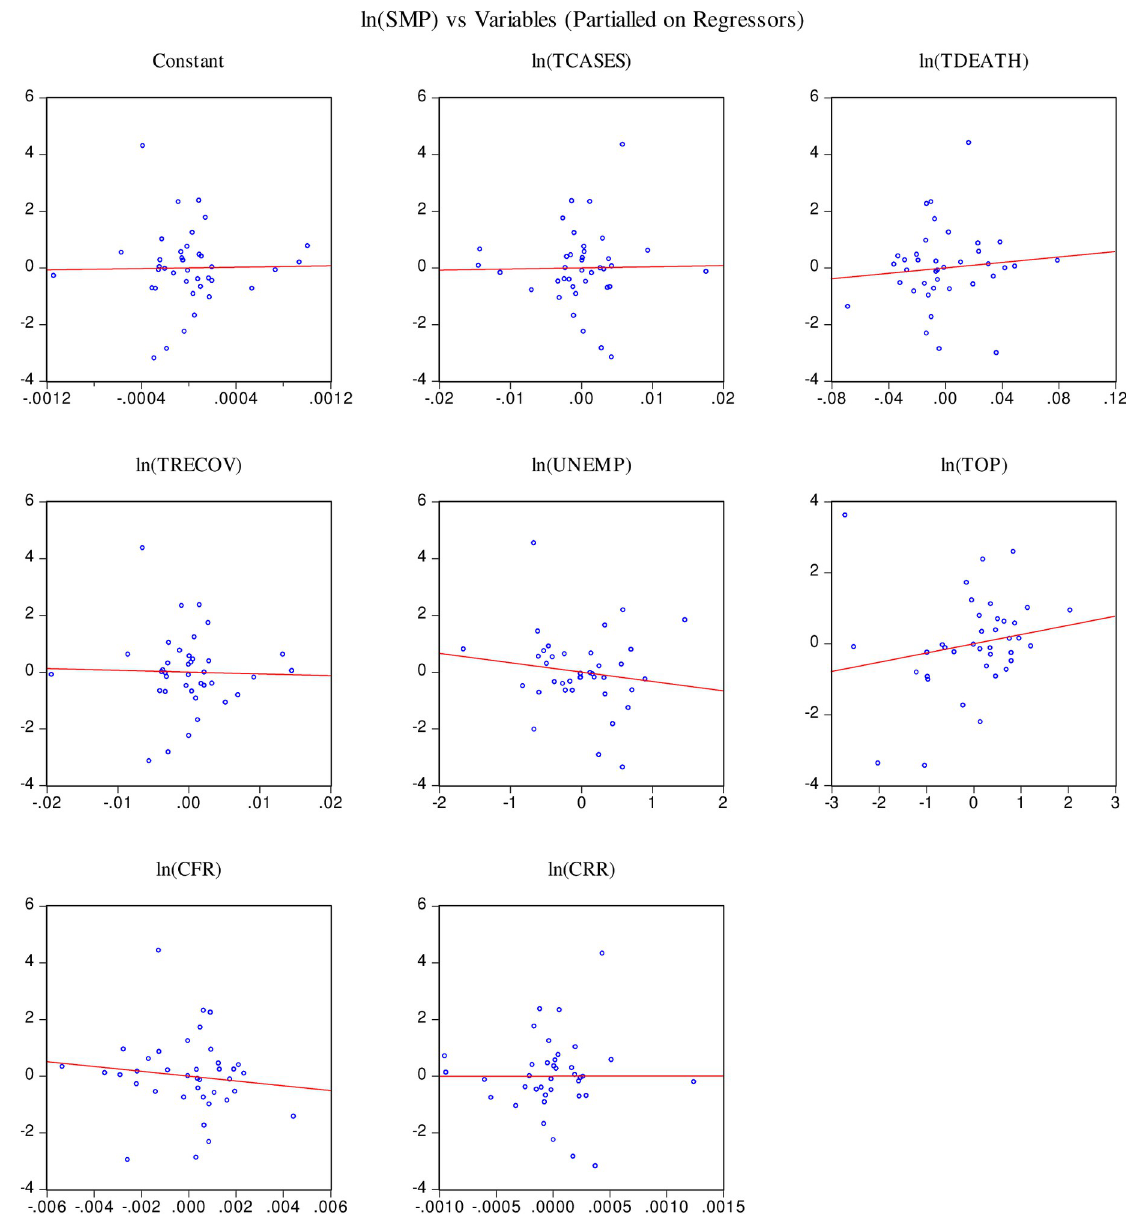
Fig 3. Leverage plots for ln(SMP). Source: Authors estimates. Note: ln(TCASES) shows natural logarithm of total cases, ln(TDEATH) shows natural logarithm of total deaths reported, ln(TRECOV) shows natural logarithm of total recovered cases, ln(GDP) shows natural logarithm of GDP, ln(SMP) shows natural logarithm of stock market performance, ln(TOP) shows natural logarithm of trade openness, ln (CFR) shows natural logarithm of case fatality ratio, ln(CRR) shows natural logarithm of case recovered ratio, and ln(UNEMP) shows natural logarithm of